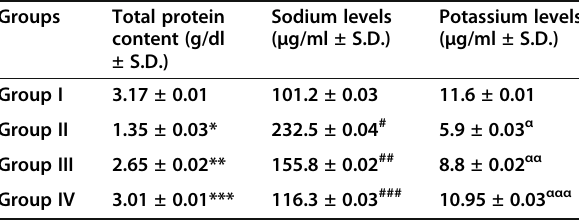
Table 5 Table showing levels of different ions in normal, cataract induced and cataract treated groups